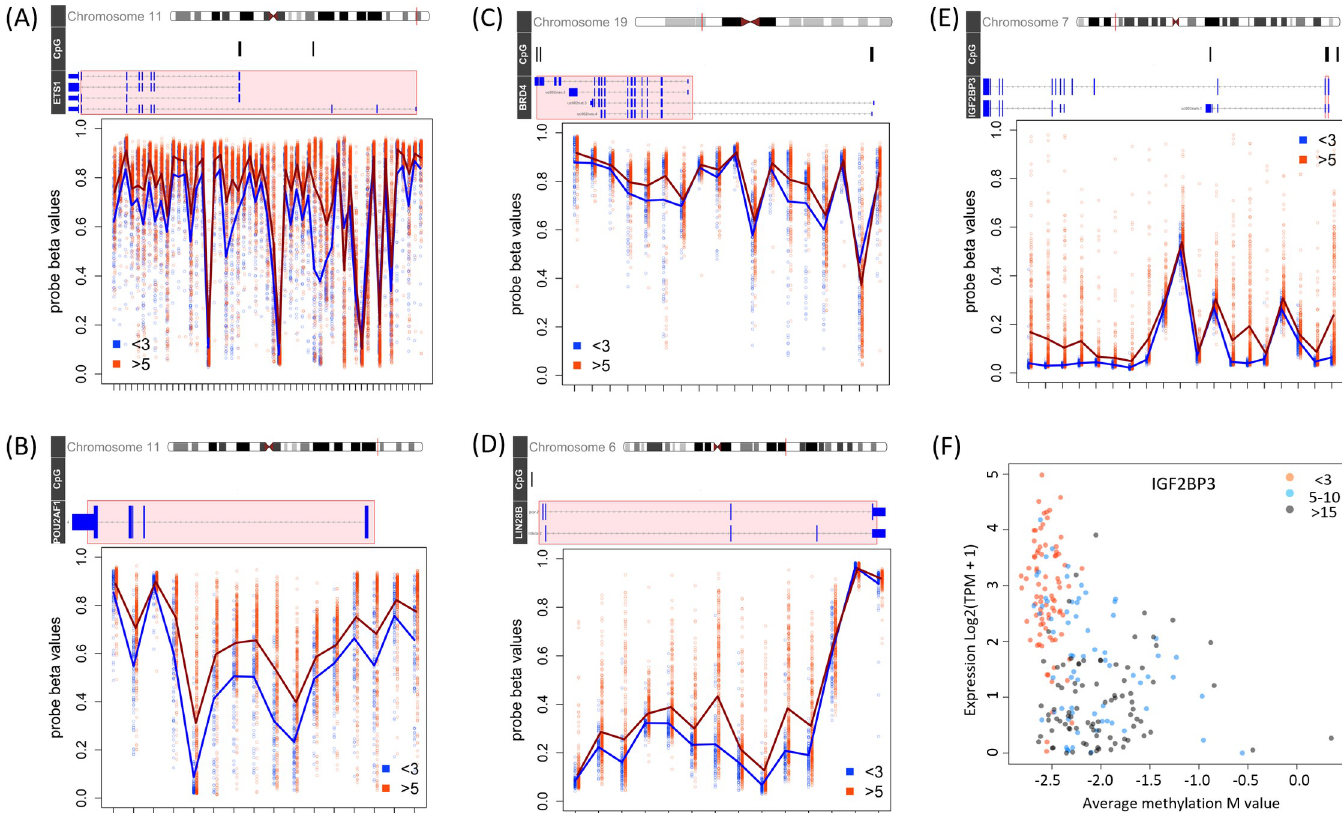
Fig 6. Five B-cell associated genes up-regulated in infant AML are hypomethylated at the DNA level. ( A-E ) Shown are differentially methylated region plots for ETS1 , BRD4 , IGF2BP3 , POU2AF1 , and LIN28B . The chromosome ideogram at the top shows the genomic location considered (red bar) in hg19 coordinates. The genome browser tracks below each ideogram show the locations of known CpG islands (black bars), and all UCSC transcript isoforms (horizontal lines, with intersecting blue bars marking exons). The super-imposed red box marks the region with differentially methylated probes displayed in detail in the panel below. The vertical axis in the differential methylation panels indicates fractional probe methylation level. CpG probes are organized in their chromosomal order along the horizontal axis. The red and blue plot points mark methylation levels in individual samples (blue = infants, red = > 5 year olds). The red and blue lines connect the mean values of CpG methylation levels per patient group. ( F ) The expression if IGF2BP3 , which is only differentially-methylated in a promoter CpG island region (panel E), is highly anti-correlated with the average methylation of all IGF2BP3 CpG probes in this region and distinctive in infant AML (red plot points).